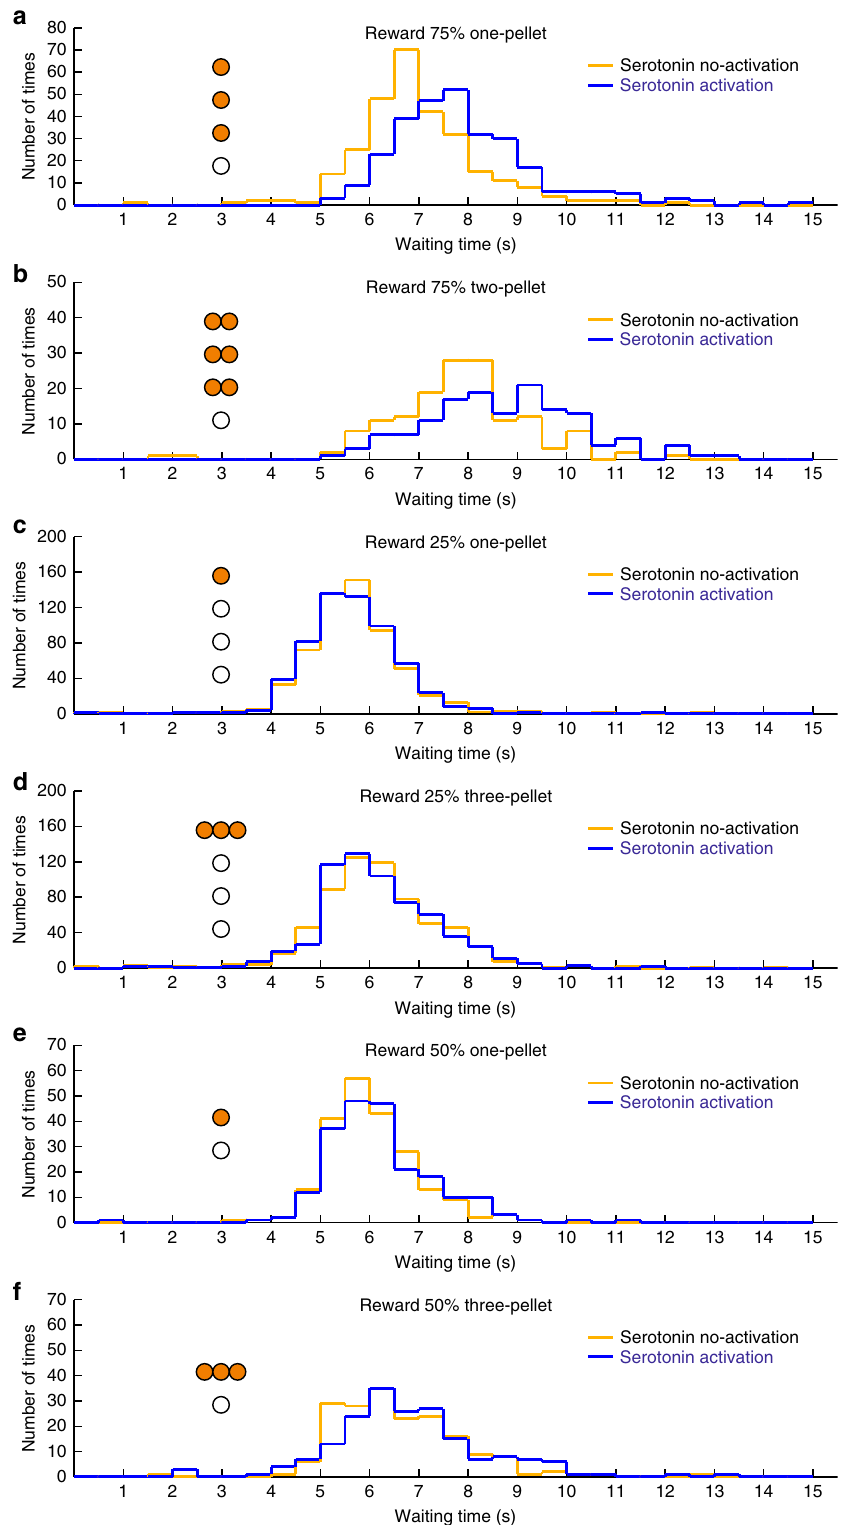
Fig. 2 Optogenetic activation of DRN serotonin neurons enhances waiting in 75% reward tests, but not in 25 or 50% reward tests. a Distribution of waiting time during omission trials in the 75% one-pellet test. b Distribution of waiting time during omission trials in the 75% two-pellet test. c Distribution of waiting time during omission trials in the 25% one-pellet test. d Distribution of waiting time during omission trials in the 25% three-pellet test. e Distribution of waiting time during omission trials in the 50% one-pellet test. f Distribution of waiting time during omission trials in the 50% three-pellet test. Orange circles illustrate the timing and numbers of food pellets presented in rewarded trials. White circles denote omission